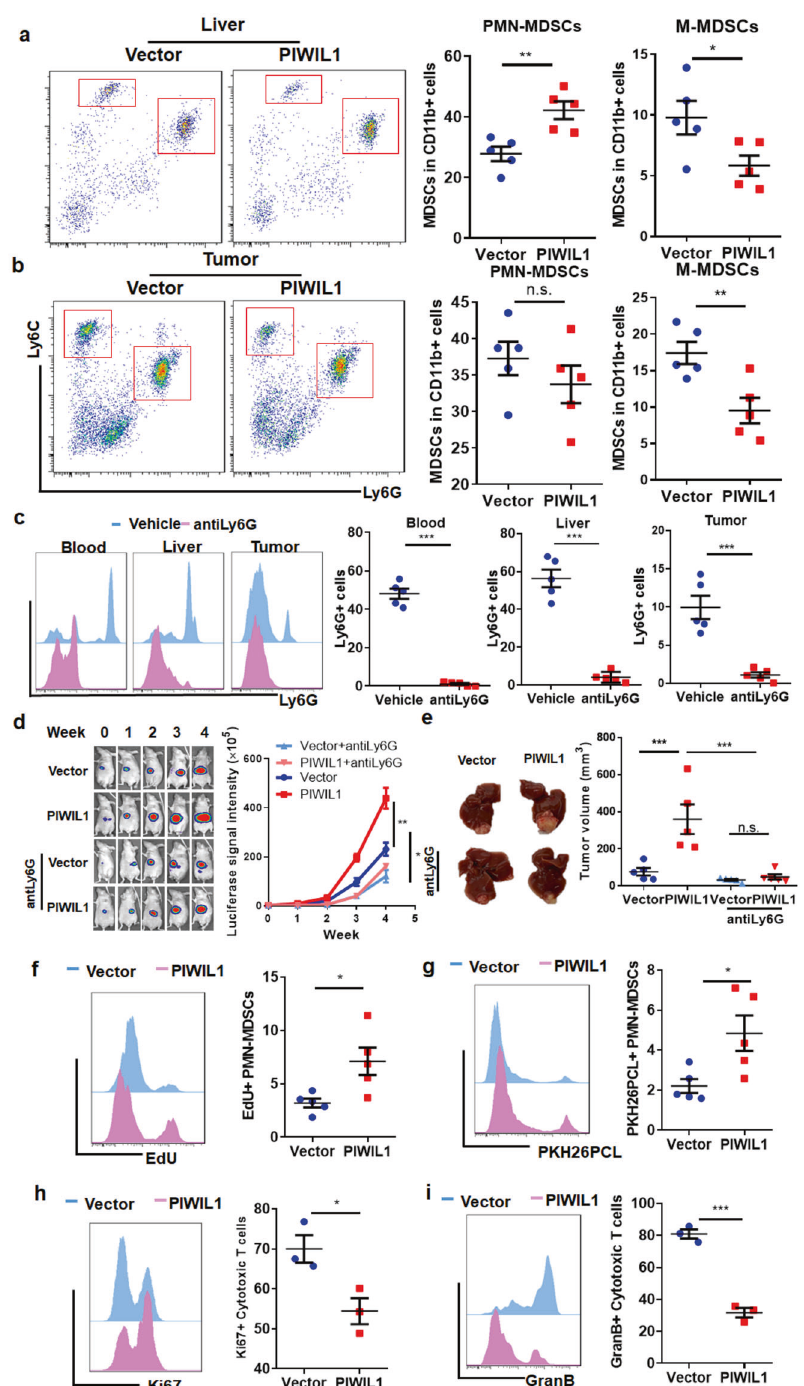
Fig. 4 PIWIL1 overexpression-induced MDSCs in the tumor microenvironment of HCC. The tumor and surrounding hepatic tissues (within 5 mm from the tumor) of orthotopic HCC mice were collected. The population of analysis of MDSCs was analyzed by fl ow cytometry; PIWIL1 overexpression signi fi cantly accumulated the PMN-MDSCs in the surrounding hepatic tissues ( a ), while the M-MDSCs population was suppressed ( b ); We then used anti-Ly6G to deplete the PMN-MDSCs population. Intraperitoneal injection of anti-Ly6G antibody (200 mg/kg, every 4 days) successfully suppressed the PMN-MDSCs population ( c ) and attenuated the PIWIL1-induced HCC growth ( d ) and tumor size ( e ); f EdU was intraperitoneally injected into the mice (10 mg/kg). Five hours after injection, mice were sacri fi ced and the EdU-incorporated PMN- MDSCs were analyzed by fl ow cytometry. Increased EdU incorporation was observed in PMN-MDSCs of PIWIL1-overexpressing orthotopic tumor; g BMDMs were isolated and stained by PKH26PCL. The PKH26PCL-positive BMDMs were then intraperitoneally injected (1 × 10 7 cells/ mice) 48 h before sacri fi ce. The in fi ltration of PKH26PCL-positive cells was signi fi cantly increased in the hepatic tissues surrounding PIWIL1- overexpressing HCC; the PMN-MDSCs in the hepatic tissues surrounding wild type or PIWIL1-overexpressing HCC were sorted and co-cultured with simulated CD8 + cytotoxic T cells. PMN-MDSCs from PIWIL1-overexpressing HCC had a more potent ability in inhibiting the expression h Ki67, a marker of cell proliferation, and i Granzyme B (GranB), a marker of activation of co-cultured stimulated CD8 + cytotoxic T cells. All experiments were performed in triplicate. * p < 0.05; ** p < 0.01; *** p <